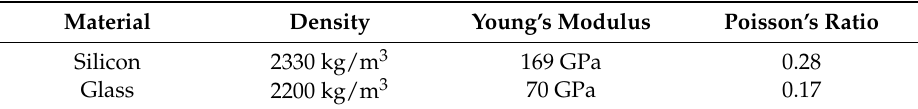
Table 2. Main material properties of the device